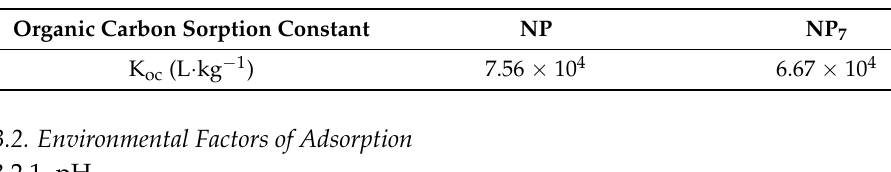
Table 3. K oc of NP and NP 7 on soil.